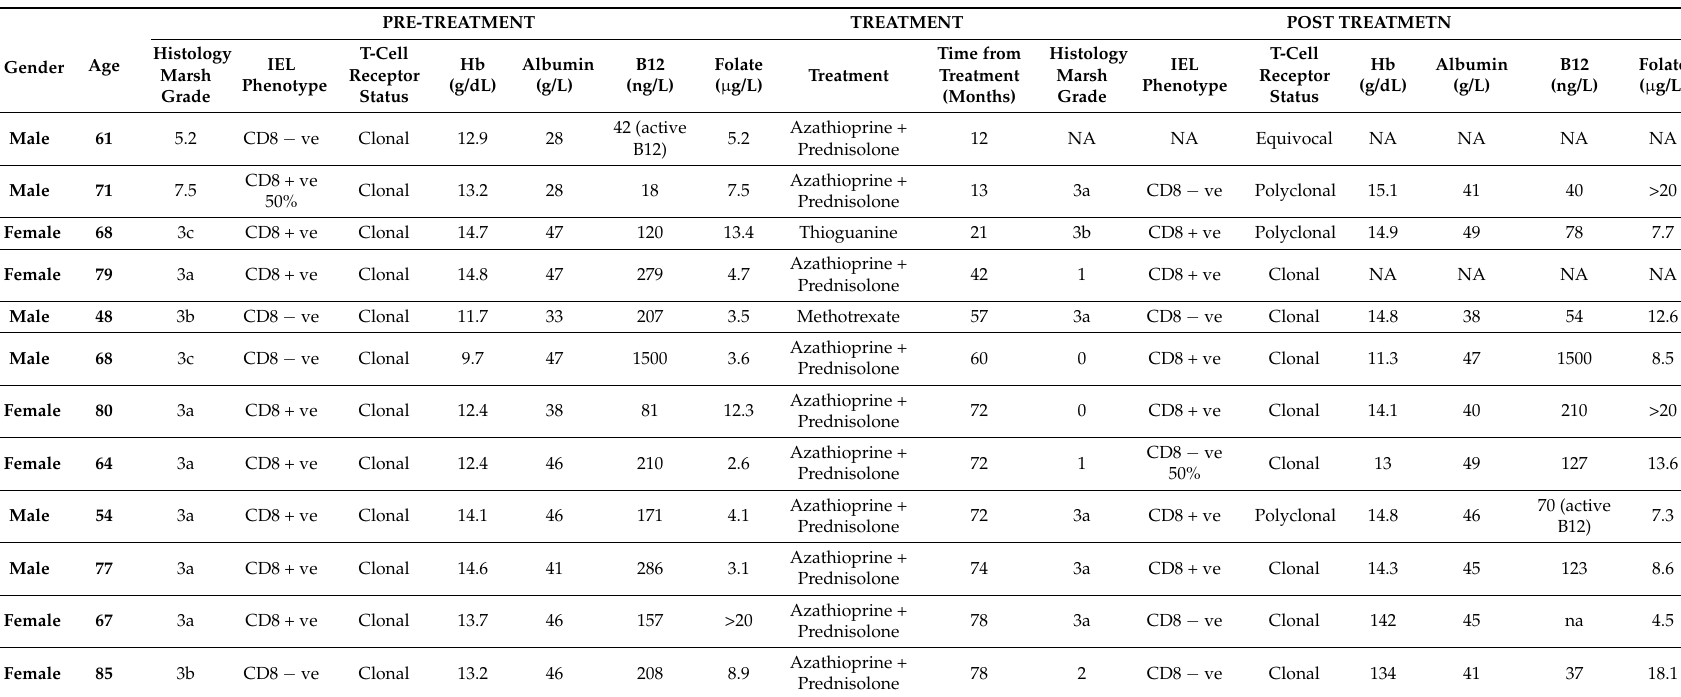
Table 4. Baseline and post-treatment follow up data for patients with refractory coeliac disease type 2 who are on ongoing